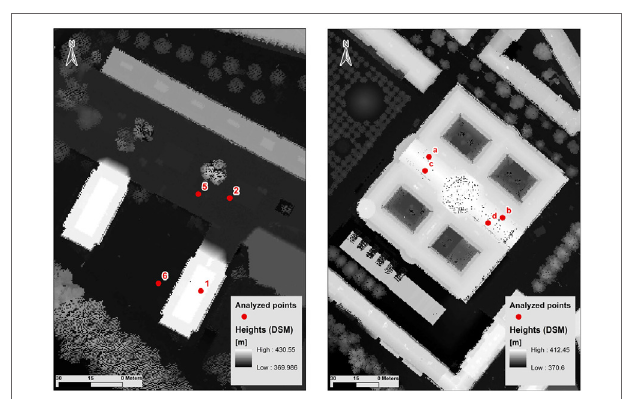
FIGURe 11 | Studied areas in Jonction (left hand-side image) and Unimail (right hand-side image) with location of points used for